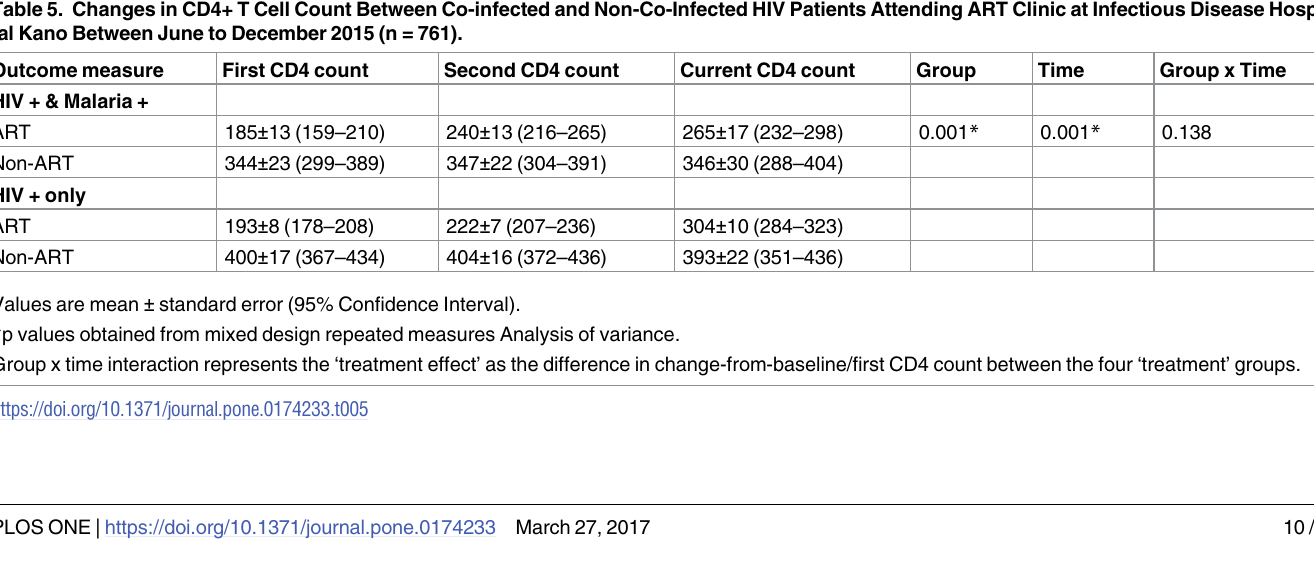
(234.6 ± 6.9) was observed among respondents on ART compared to those not on ART (372.5 ± 13.2) (F = 85.146, df = 1, 757, p < 0.001, mean difference = -137.9). Finally, we exam- ined group x time interaction (CD4 count (cid:3) co-infection status (cid:3) ART status) as the difference in change-from-baseline/first CD4 count between the four ‘treatment’ groups. Our results showed that there was no significant difference in mean CD4 count changes over time between the four groups (i.e. co-infected on ART, co-infected non-ART, HIV positive without malaria on ART, HIV without malaria non-ART) (F = 2.120, df = 1.328, 1005.422, p = 0.138) (Table 5). Changes in CD4 count in association to malaria parasite co-infection and HIV only in relation to ART status interaction presented in Fig 1.